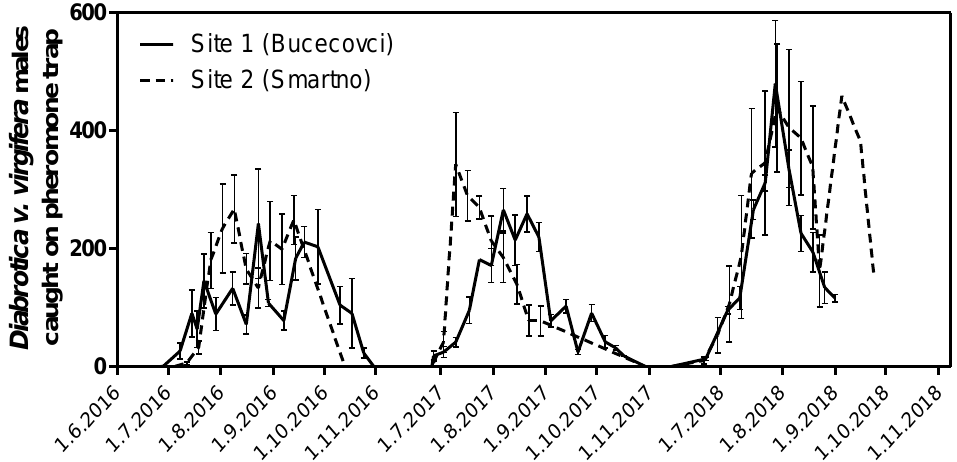
Figure 1. Diabrotica v. virgifera males caught on PAL pheromone traps 1 km away from sites 1 and 2 in 2016–2018 ( n = 3 for site 1 and n = 9 for site 2).